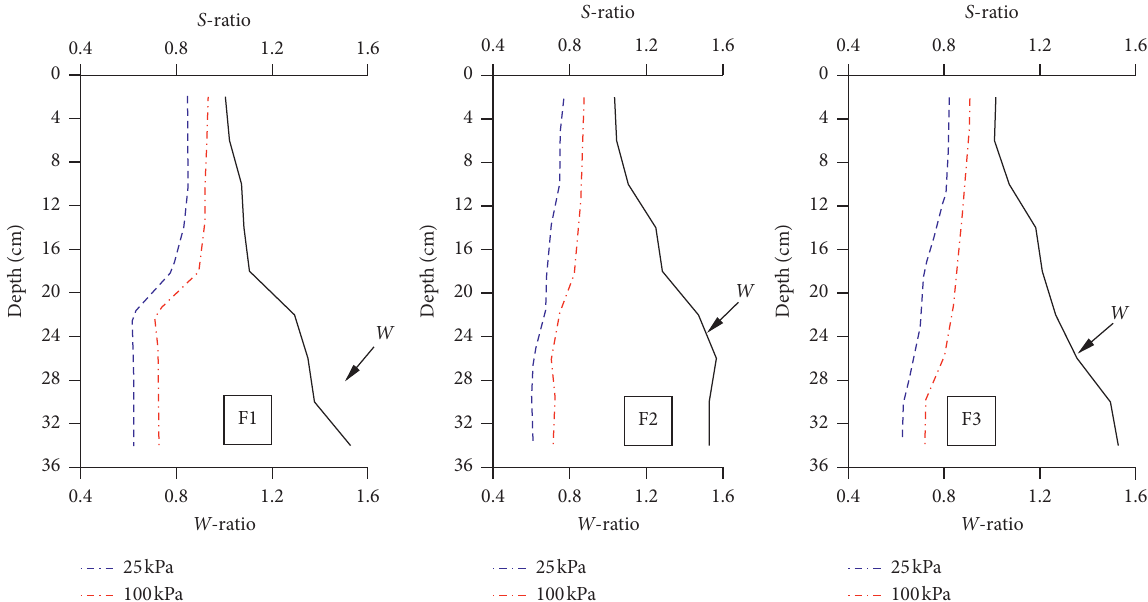
Figure 8: Shear strength ratio ( S -ratio) versus water content ratio ( W -ratio) at the expansive soil columns’ different depths after the freeze- thaw process.